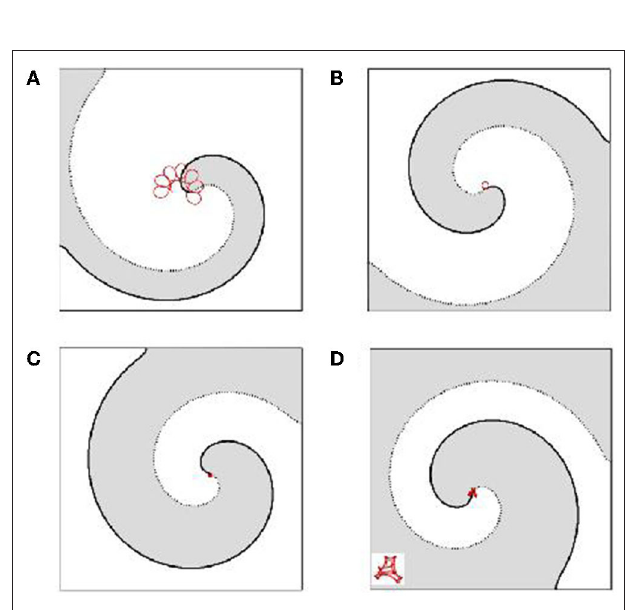
FIGURE 4 | Spiral waves dynamics obtained for the system (1)–(3) with ǫ = 0.005, k ǫ = 4, and b = 0.01 for different values of the parameter a . In (A) a = 0.22, in (B) a = 0.4, in (C) a = 0.6, and in (D) a = 0.8. Thick and dotted solids represent the wave front and back, correspondingly. The trajectory of the spiral wave tip is shown in red. In the left lower corner of (D) the trajectory is